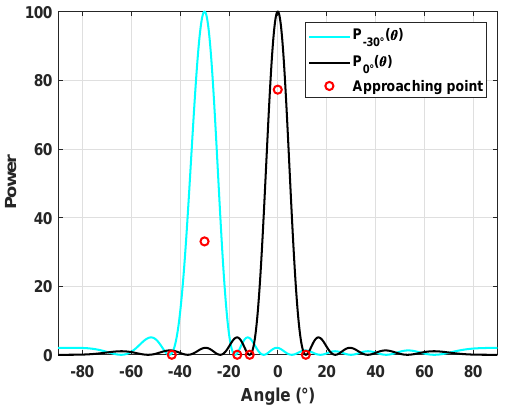
Figure 3. The representation of approaching